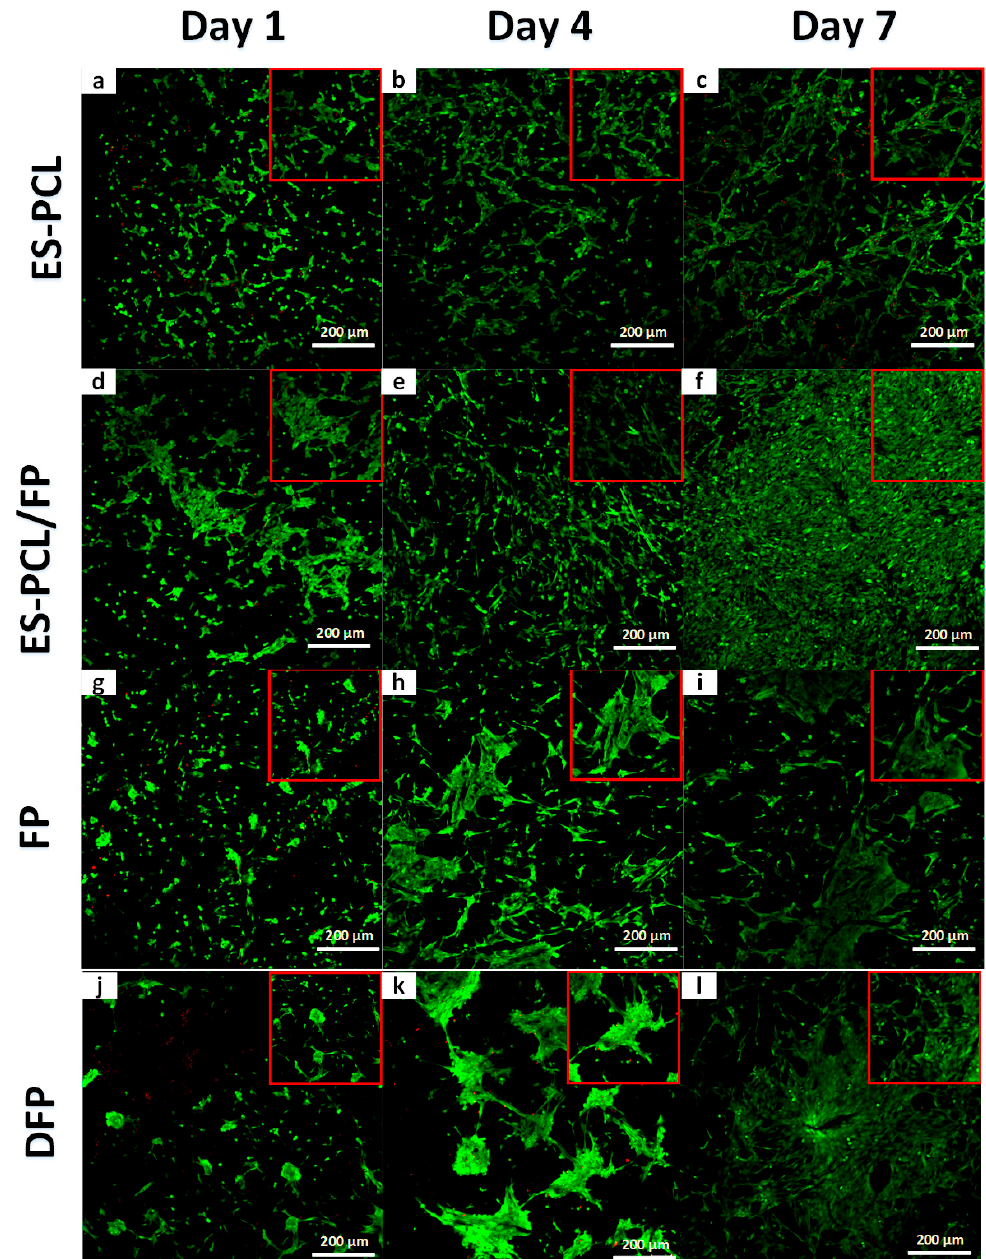
Figure 5. Cell viability analysis. Live/dead confocal of hFOB plotted separately for each individual substrate ES-PCL ( a–c ), ES-PCL/FP ( d–f ), FP ( g–i ), and DFP ( j–l ) on different days. The magnification and resolution of all images are the same.